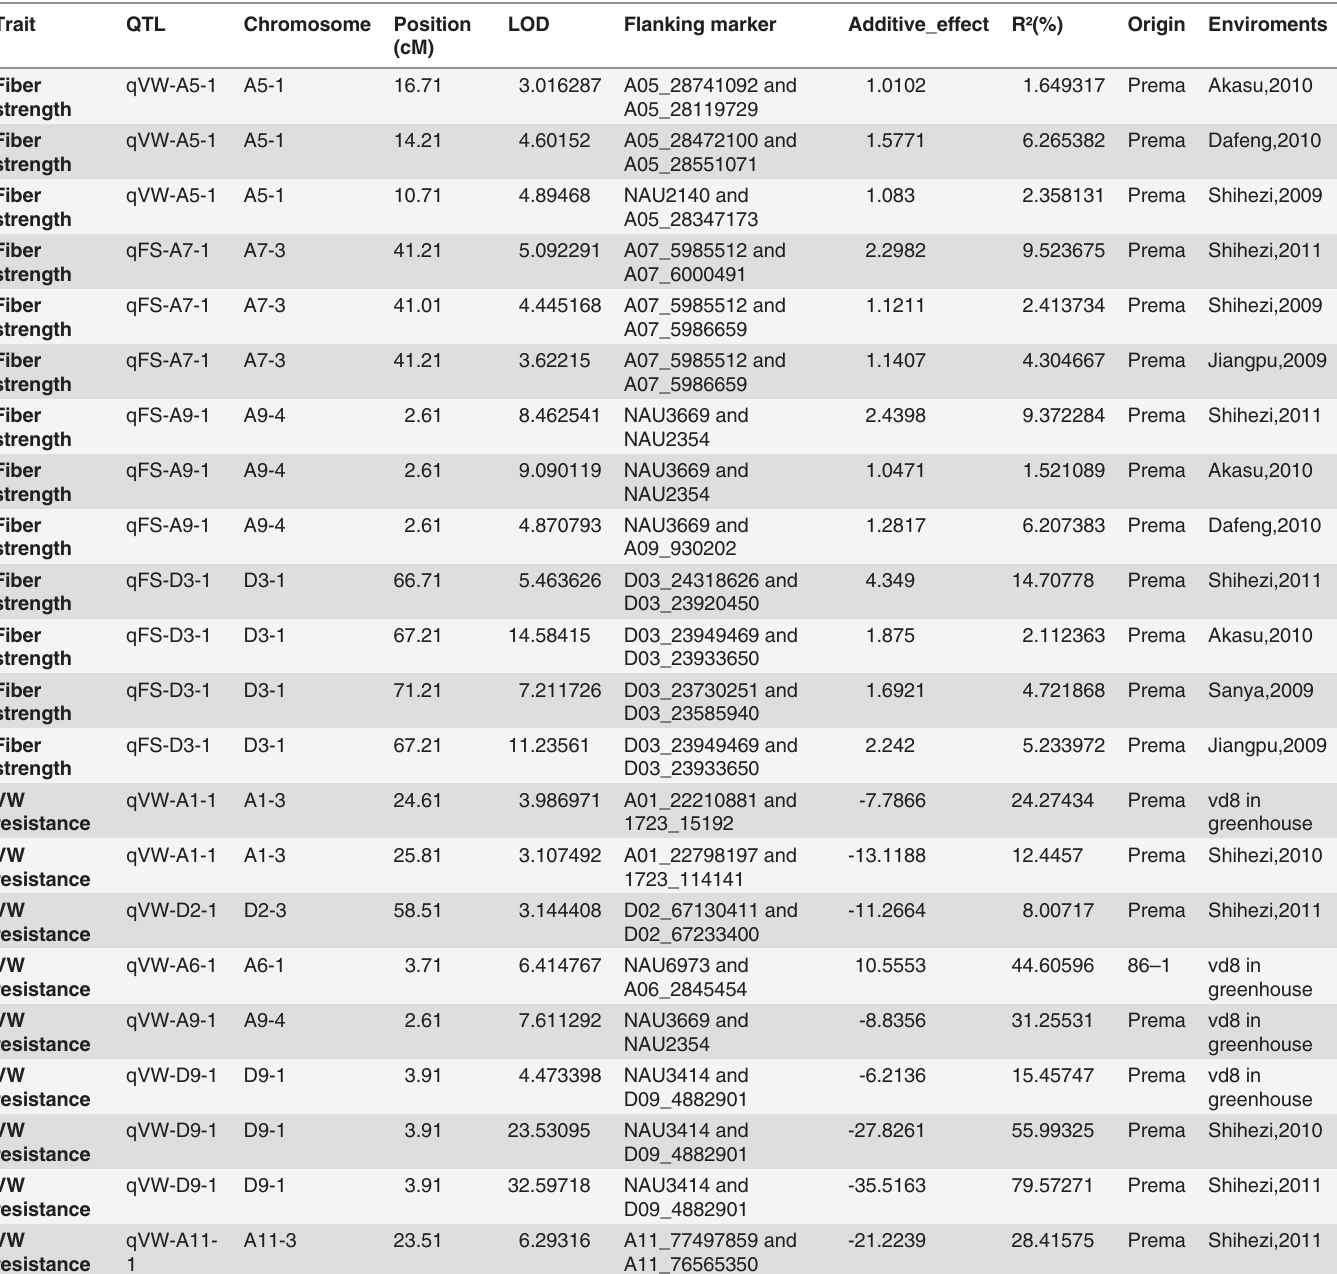
Table 4. QTLs fiber strength and VW-resistance detected by CIM in the RILs in different environments.